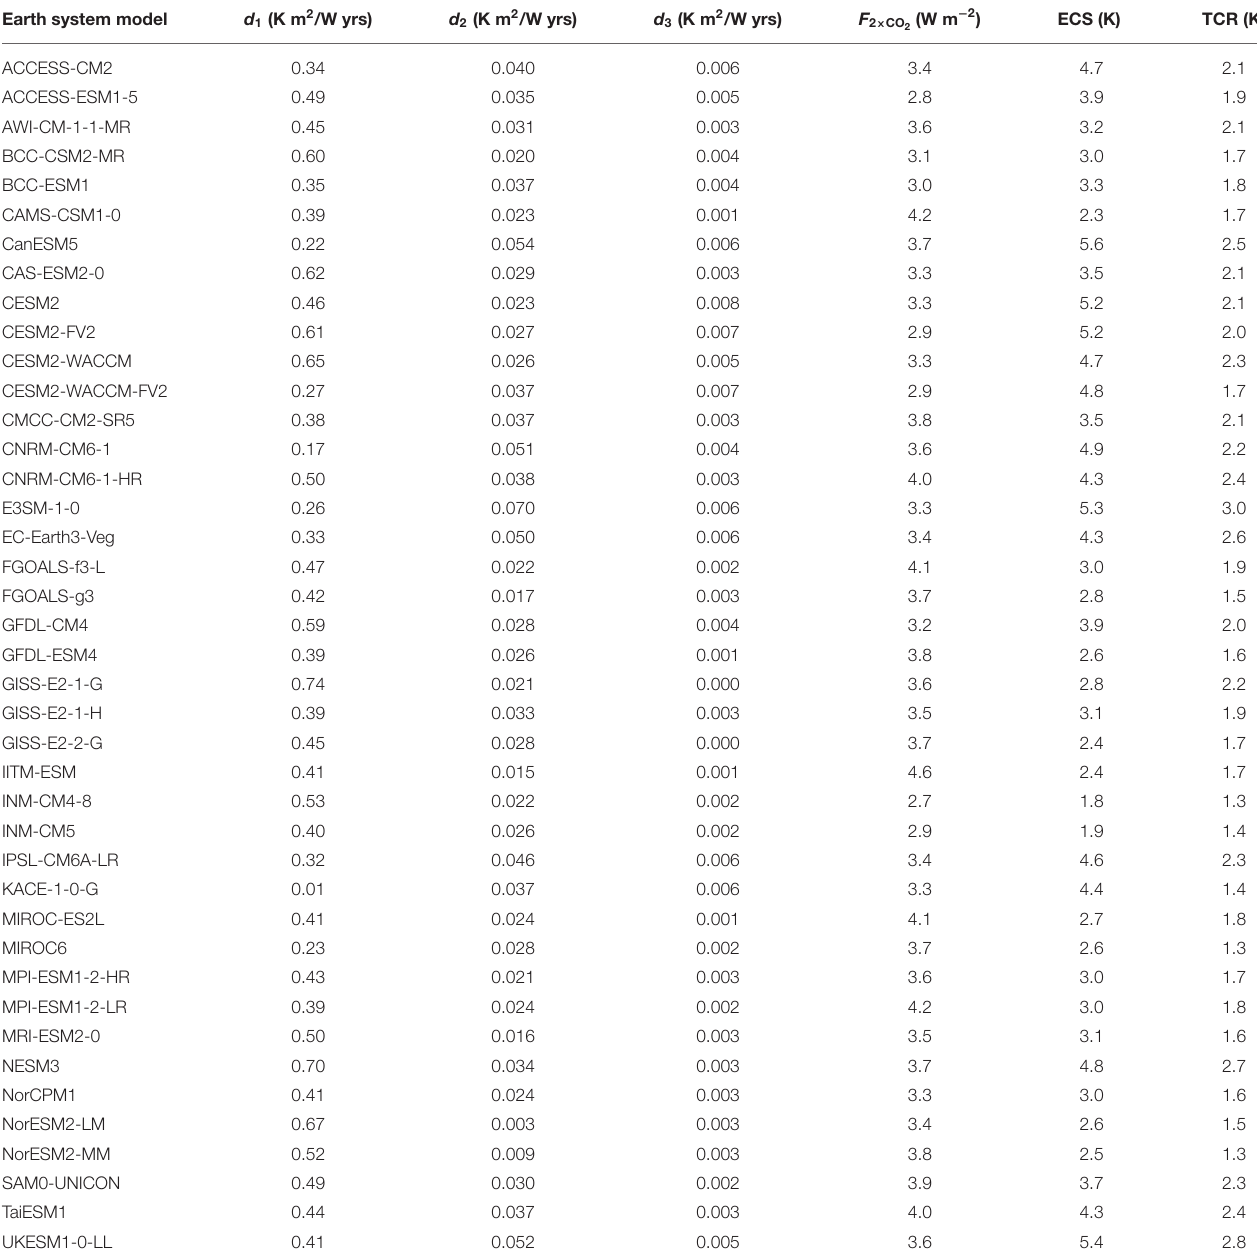
TABLE 1 | The parameters d 1 , d 2 , d 3 are estimated weights for the three temperature responses with time constants 0.5, 10, 100 yrs, respectively, for the 41 CMIP6 models. Earth system